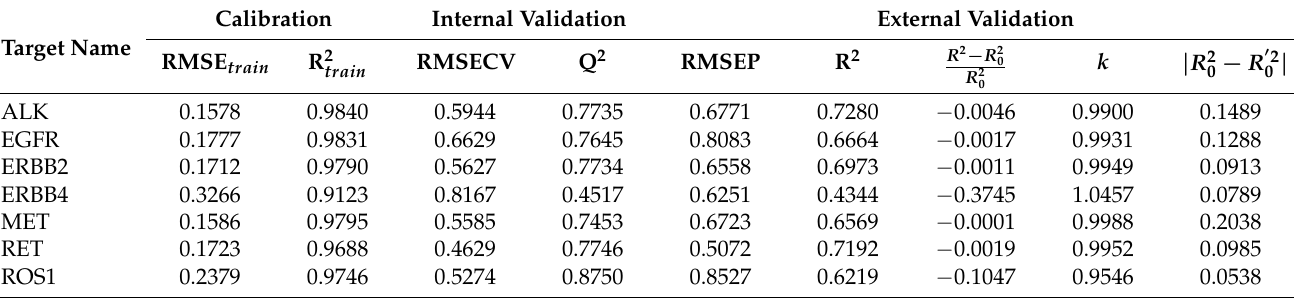
Table 2. Statistical results of seven tyrosine kinases activity prediction from our multitask